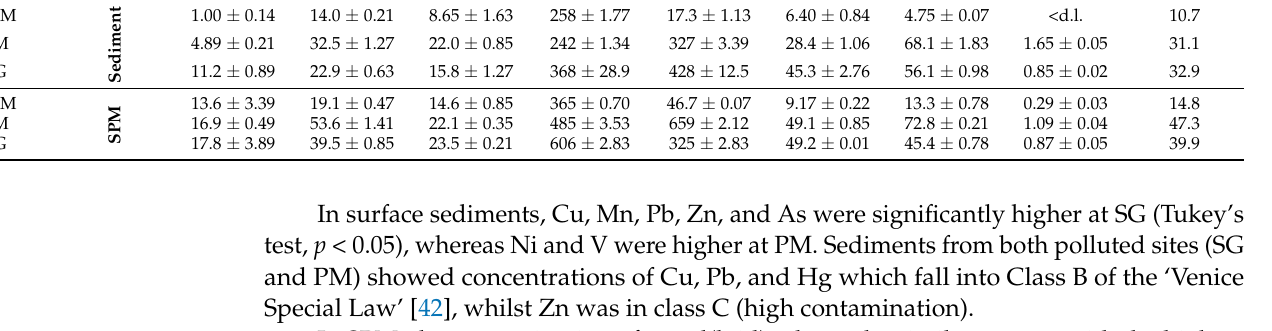
Table 1. Metal(loid) concentrations (mean ± SD) ( µ g g − 1 dw) in surface sediments and SPM collected at LV: SMM—Santa Maria del Mare; PM—Porto Marghera; SG—San Giuliano; MPI—metal pollution index.